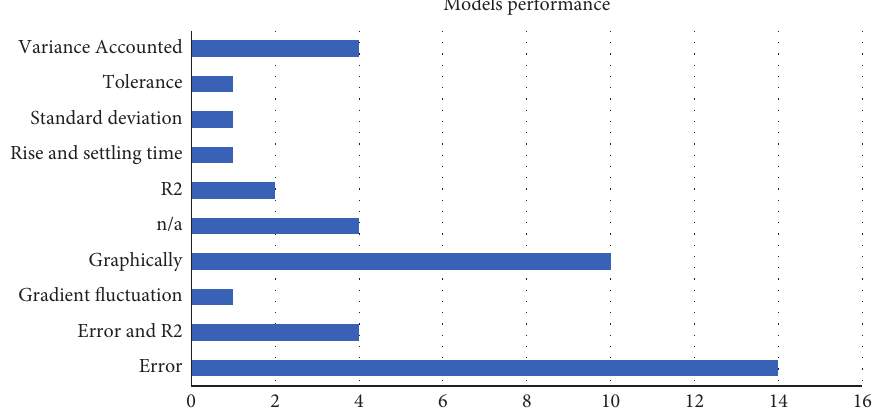
Figure 9: Models performance by analysed